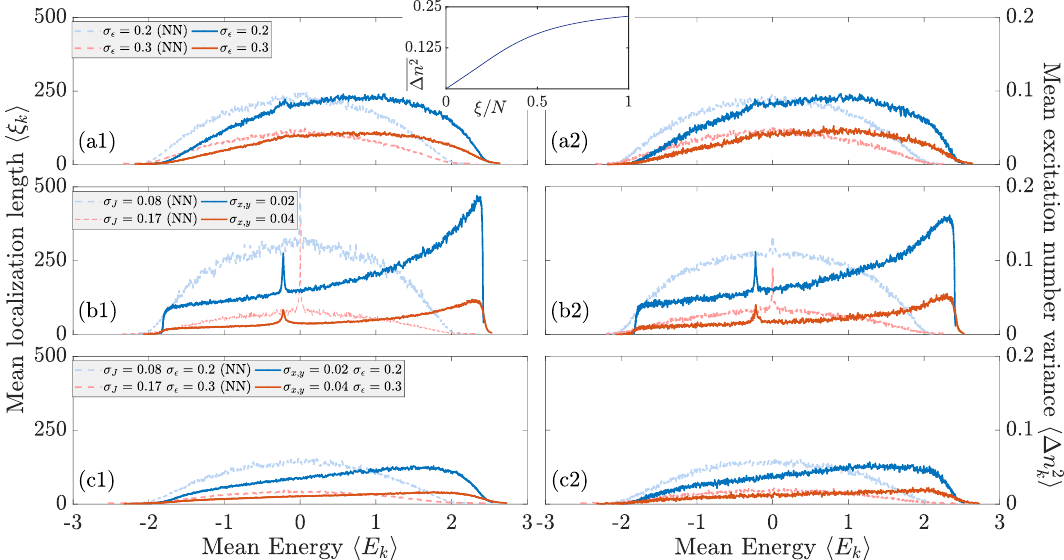
〉 (in units of lattice spacing a = 1) [ left panels Figure 2: Mean localization length 〈 ξ k 〉 [ right panels (a2), (a1), (b1), (c1) ] , and mean excitation number variance 〈 ∆ n 2 k 〉 (in units of J = C / a 3 ) of the k -th eigenstate (b2), (c2) ] vs the mean energy 〈 E k 3 of a chain of N = 1000 spins obtained upon averaging over 1000 independent real- izations of disordered chains with long-range exchange interactions (solid lines with filled circles) and nearest-neighbor interactions (dashed lines), for (a) energy (diag- onal) disorder with standard deviation σ ε , (b) position (off-diagonal) disorder with standard deviation σ or σ , and (c) combination of energy and position disorder. x , y J For illustrative purposes, we use in (a) and (b) the strength of the diagonal σ ε and off-diagonal σ (or σ ) disorders that lead to comparable localization lengths. In- x , y J set shows the averaged number variance ∆ n 2 vs ξ/ N , as described in the